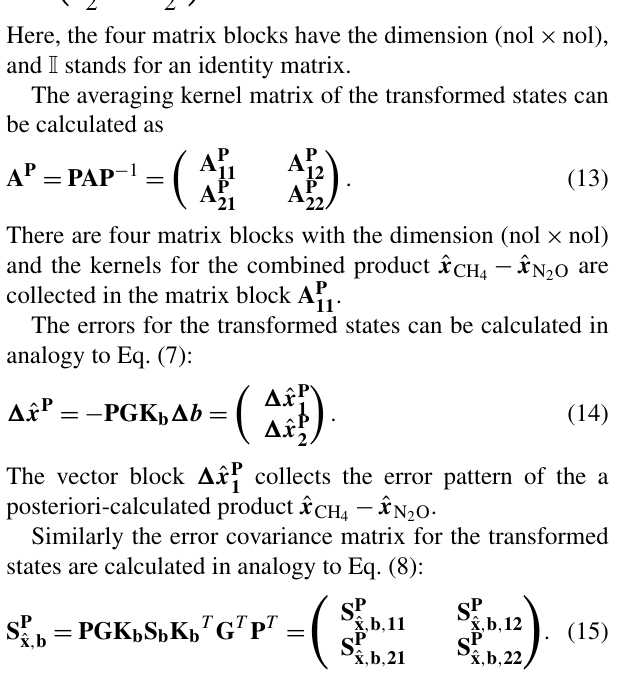
retrievals of atmospheric temperatures (EUMETSAT, 2017), which are subsequently used as a priori data by the MUSICA